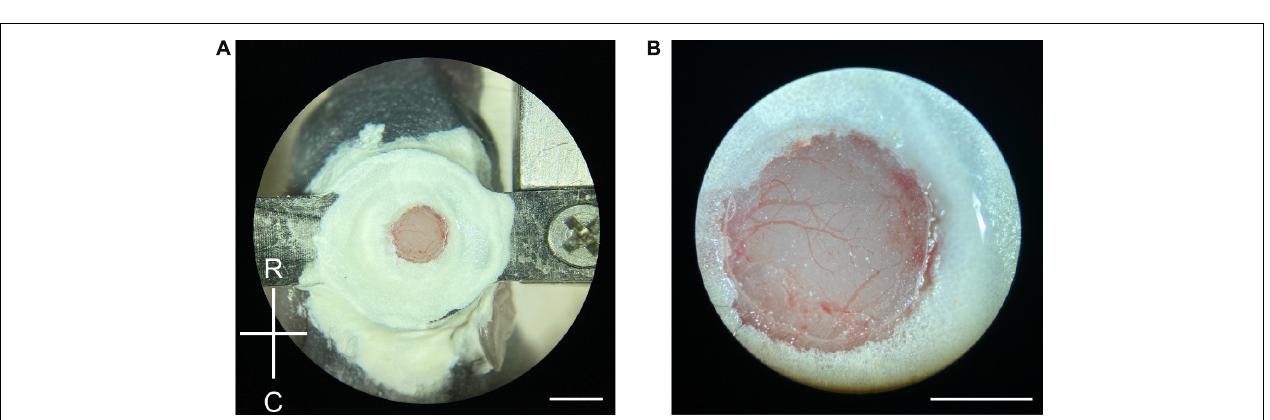
FIGURE 1 | Head plate design and attachment. (A) Design and key measurements for the titanium head plate used in neonatal mice. (B) A P6 mouse pup stabilized for surgery, after the head plate was attached with Metabond and screwed into a fork-shaped holder with two 1/8” screws. (C) A close-up view of the exposed skull after the head plate was attached, before the craniotomy was made. R, rostral; C, caudal.